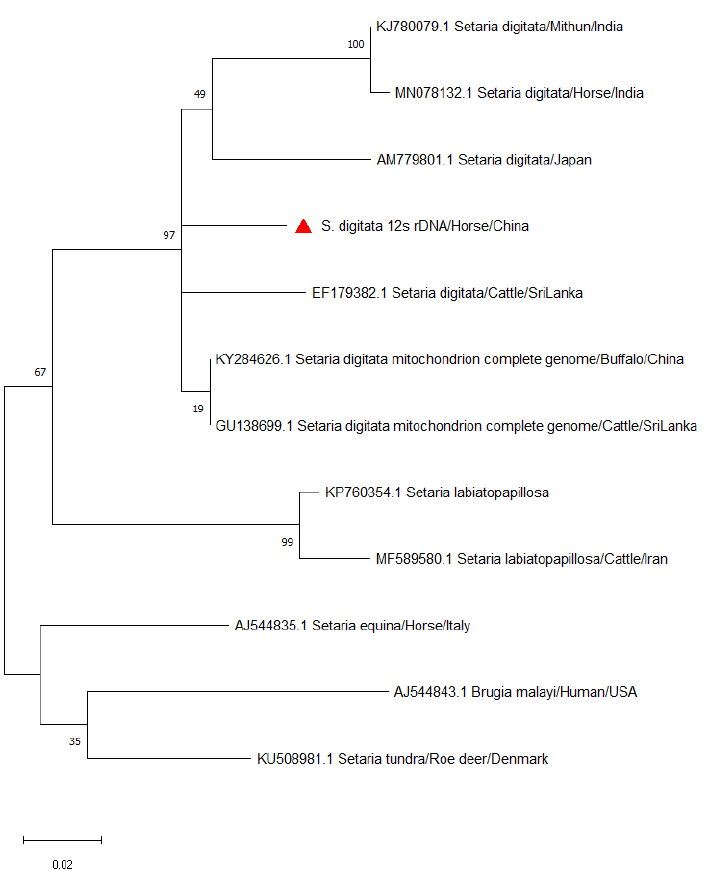
Figure 3. A mind-point rooted phylogenetic tree, inferred from 12SrDNA nucleotide sequences using the Maximum Likelihood method in MEGA X after Kimura-2 correction. Scale bar indicates the proportion of sites changing along each branch. Accession numbers of all sequences used for tree analyses are given. The sequence generated in this study was marked as red